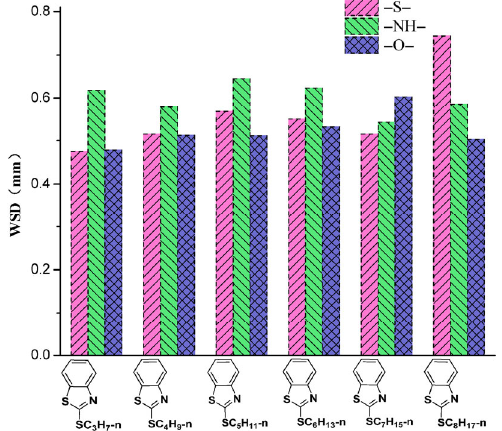
Fig. 15 The wear scar width of each steel ball when lubricating with thiobenzothiazole compounds and their isosteres in triisodecyl trimellitate.